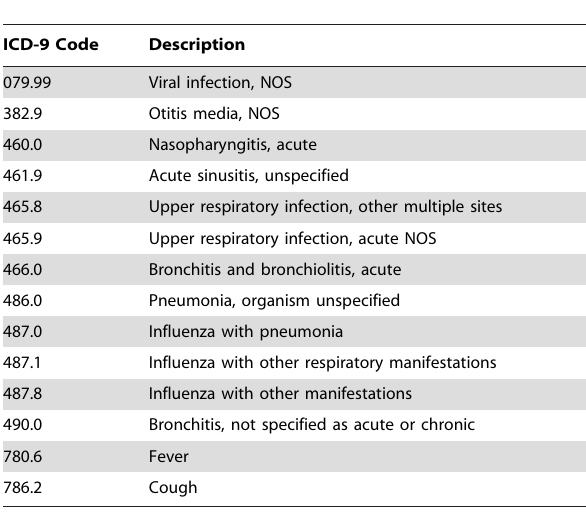
Table 1. ICD-9 Codes Used To Identify Influenza-like